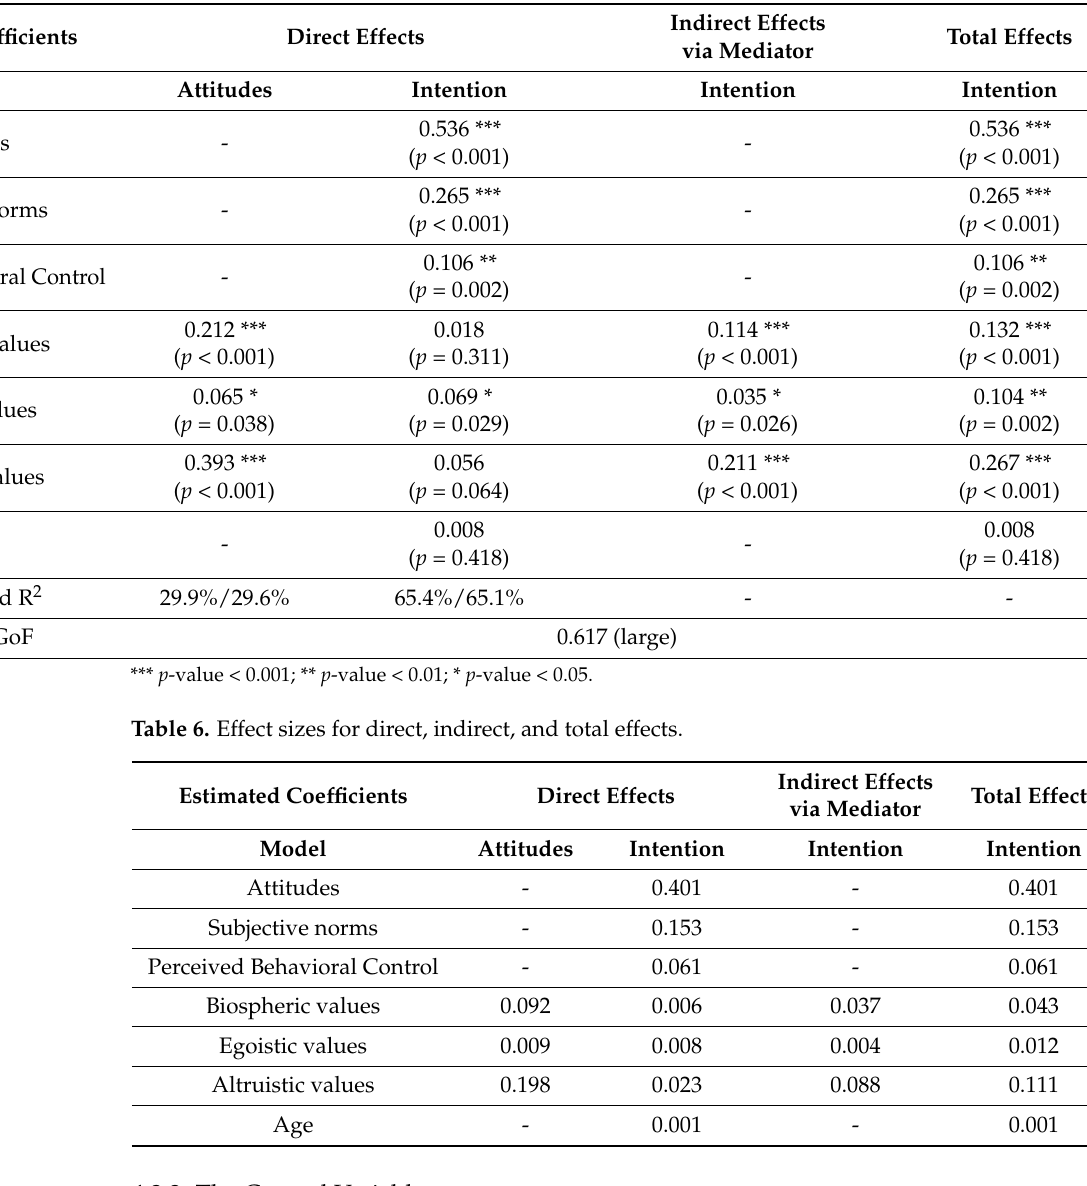
Table 5. Path coefficients, with p -values in parentheses.